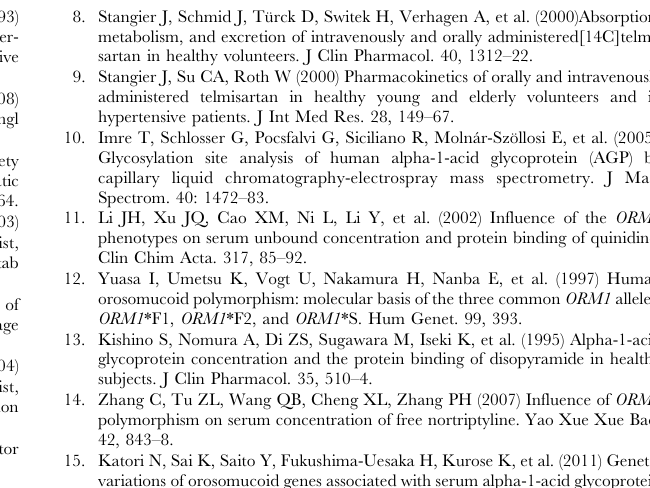
Table 2, the MAF of ABCC2 C3972T and G1249A , ABCB1 C3435T, SLCO1B3 T334G almost be similar in three main populations. While the frequencies of the alleles ABCC2 -24T, ABCG2 421G shown a apparent decrease in ASW population.